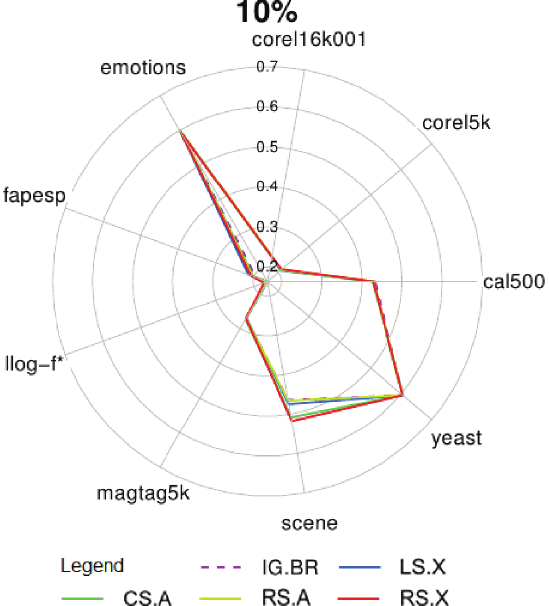
Figure 4: F-Measure performance of the LCFS set- tings and IG-BR in terms of the quality of BRkNN-b classifiers generated using | X (cid:6) | = 10% M of the se- lected